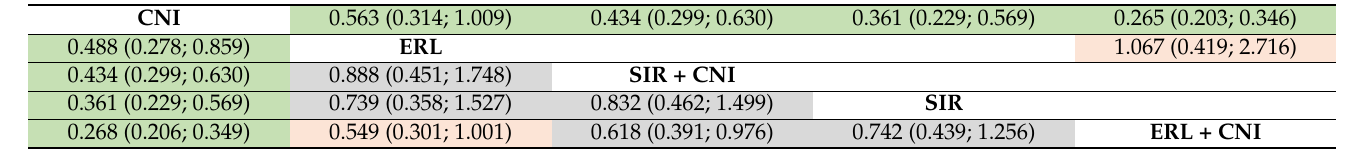
Table 1. League table (network estimates in lower triangle, direct estimates in upper triangle). Green: direct comparisons available, consistent with indirect network estimates. Orange: direct comparison available, but inconsistent with network estimate. Grey: network estimates available.